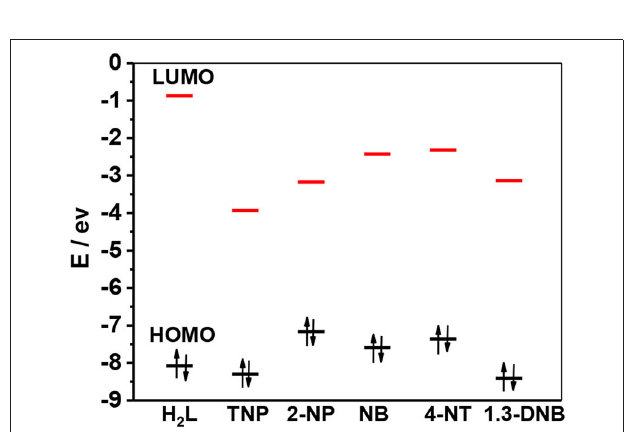
SCHEME 2 | HOMO and LUMO energy levels for the free H 2 L and selected explosives.